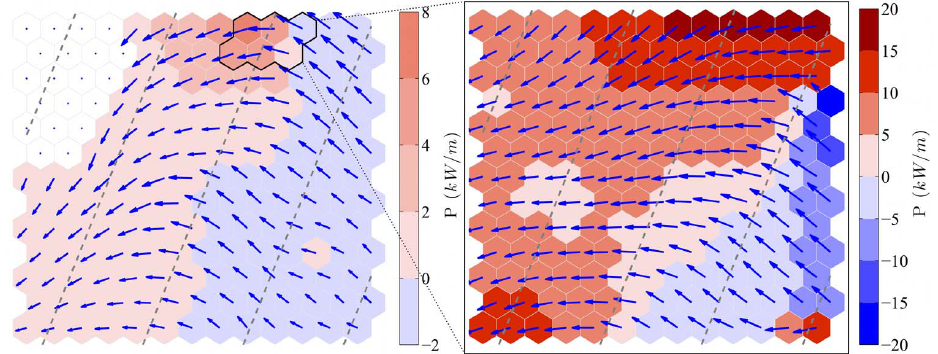
Figure 14. Application of TSOM: assessment of the longshore flux of wave energy P in shallow water, after single-step SOM (left panel) and resulting from the TSOM extreme wave climate (right panel and cells within black solid line in the left panel). Mean wave directions at Acqua Alta tower (blue arrows) indicate contributions of different meteorological conditions: positive mainly due to Bora (180 ≤ θ m ≤ 270 ◦ N), negative to Sirocco (270 <θ m ≤ 360 ◦ N). Land wind events (white cells) have been excluded, and the direction of the shoreline (270 ◦ N) is shown as gray dashed lines.